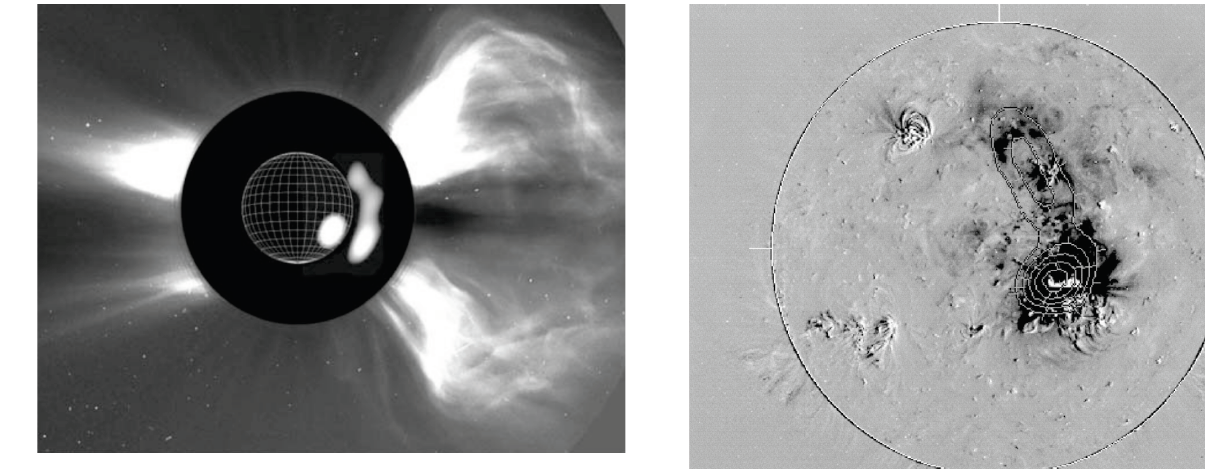
Fig. 4. From Pohjolainen et al. (2001) on 2 May 1998 CME event. EIT difference image showing coronal dimming (black regions) overlaid with 236MHz Nancay Radio Telescope (NRT) moving continuum radio source isocontours. Note how well the non- thermal radio emission matches the location where the dimmings subsequently appear (EIT difference image: 14:10–13:41UT; NRT 236MHz contours: